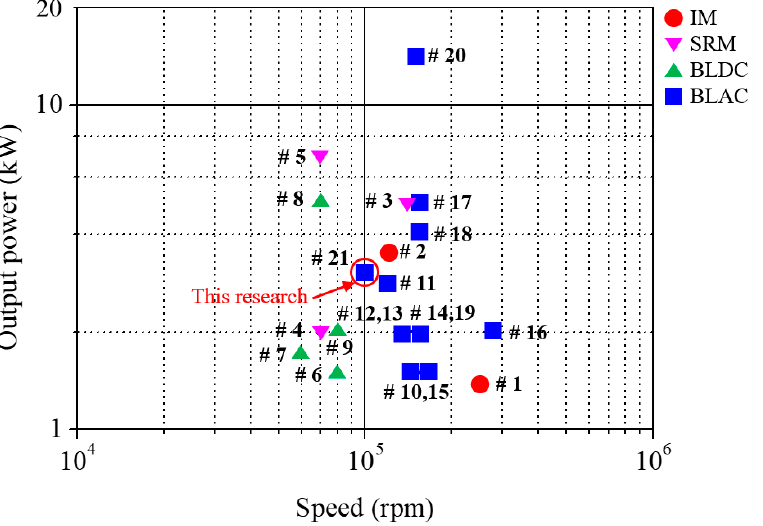
Figure 1. High-speed motors of electric turbocharger output power versus speed for different machine topologies. Table 1. High-speed machines for electric turbochargers with 12 V to 48 V battery